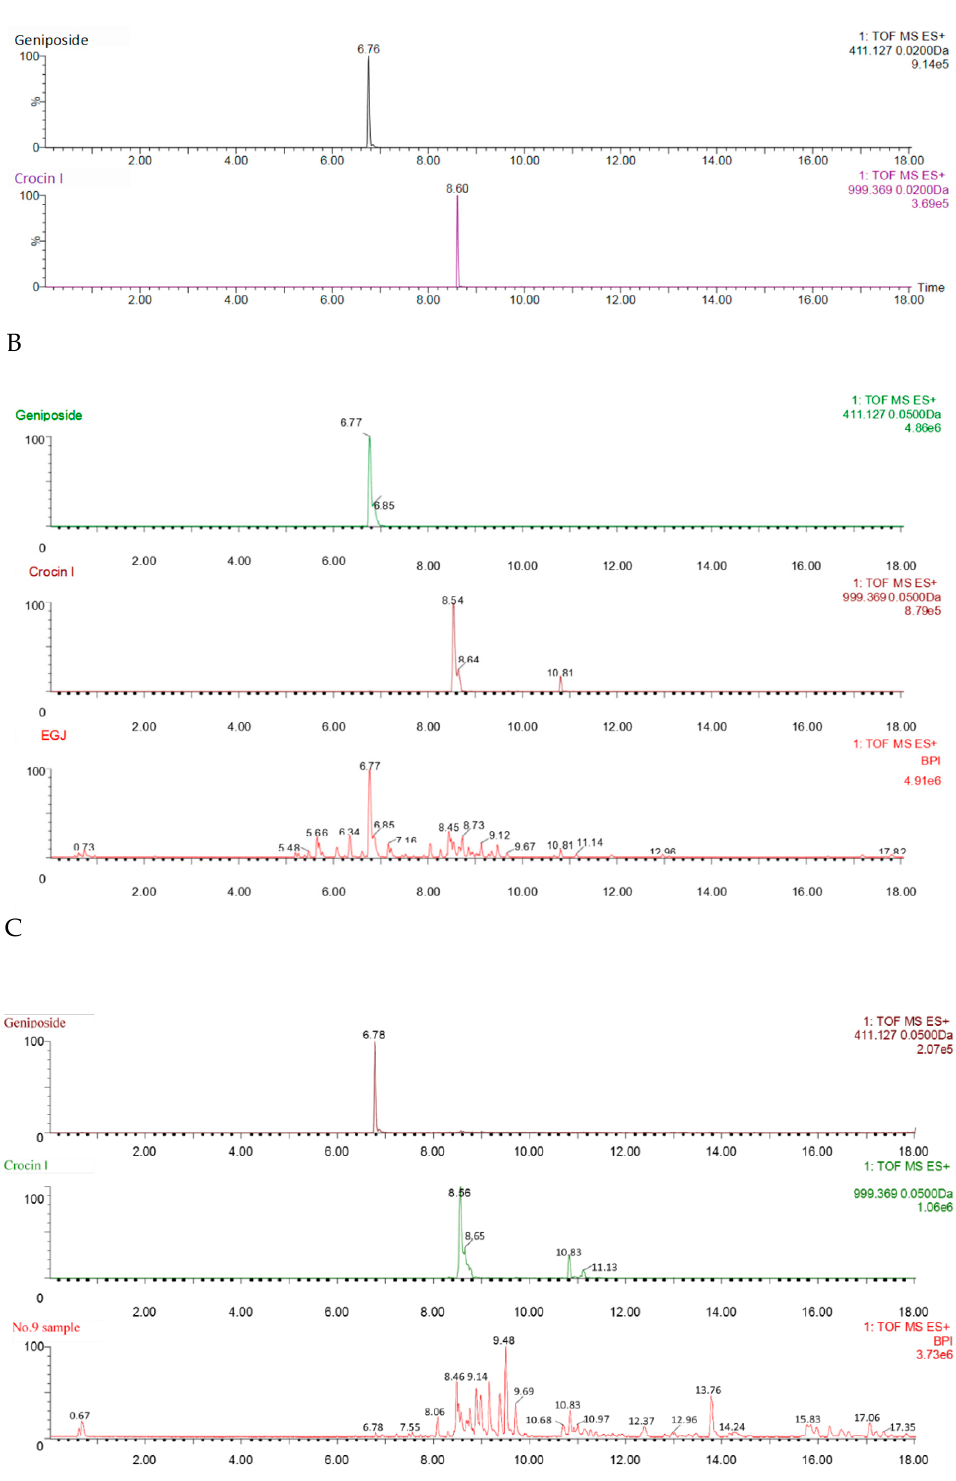
Figure 3. ( A ) The geniposide and crocin I standards, ( B ) the crude EGJ, and ( C ) the No.9 sample.